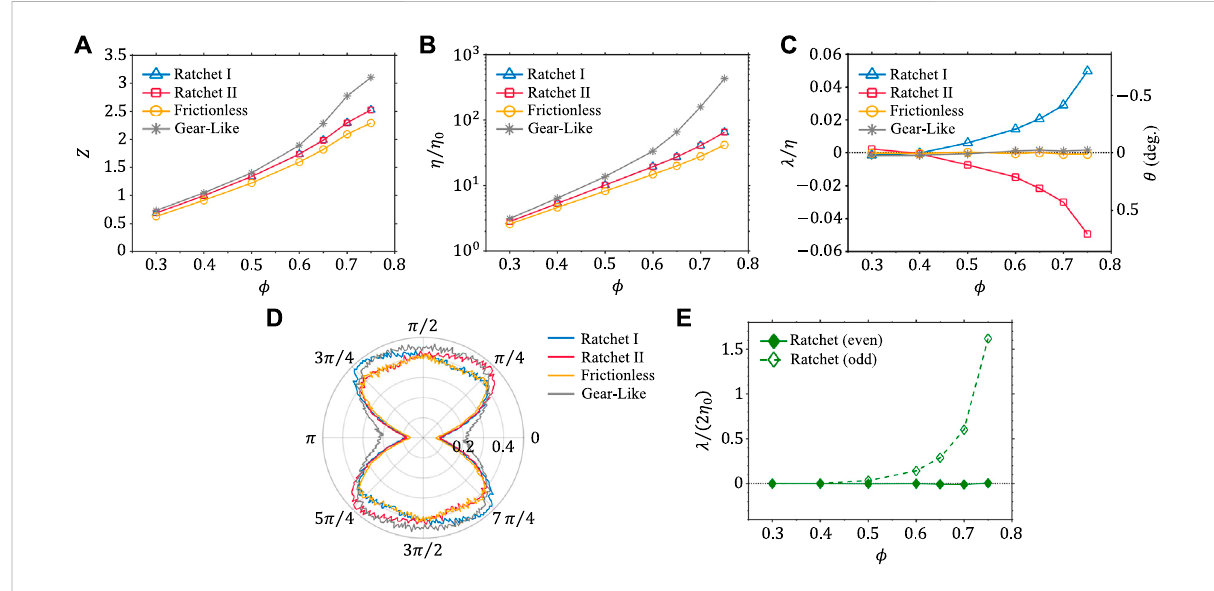
FIGURE 4 (A) Average contact number Z , (B) relative extensional viscosity η / η 0 , and (C) ratio of non-dissipation response function to extensional viscosity λ / η andcorrespondingreorientationangle θ asafunctionofparticlearealfraction ϕ forvarioustypesofparticlesinimposedplanarextensional fl ows. (D) Polar plot of the angular contact distribution for various types of particles in imposed planar extensional fl ows. The radial axis represents the distribution probability P ( θ ). (E) Even and odd components of scaled non-dissipation response function λ /(2 η 0 ) as a function of ϕ for ratchet particles. In the fi gures, error bars are not shown because they are smaller than the